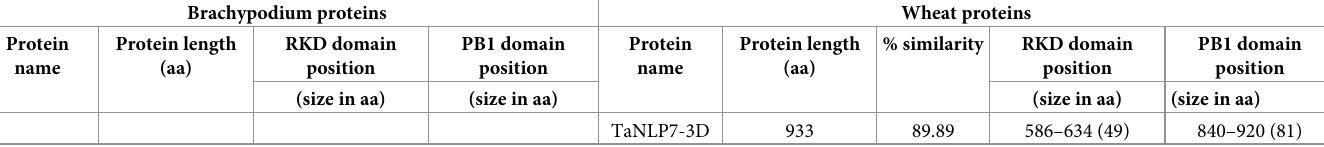
predicted 3D structures (S5 Table). The use of Ramachandran plot for evaluation of the accu- racy of protein structures is known and has been emphasized in several recent studies [27, 66]. The 3D structures of TaRKDs and TaNLPs have been submitted to Protein Model Database (PMDB) (https://bioinformatics.cineca.it/PMDB/) [67], which can be freely accessed (S5 Table). Alignment, subcellular localization and functional annotation of 3D structures. The 3D structures of three TaRKDs and four TaNLPs had significant per cent similarity with corre- sponding 3D structures of BdRKDs [range of similarity = 36.97% (TaRKD3-7A) to 88.14% (TaRKD6-2A)] and BdNLPs [range of similarity = 75.77% (TaNLP4-2A) to 95.99 (TaNLP7- 3A)], respectively (S4 Fig and S6 Table). The 3D structures of the remaining four proteins from RKD sub-family (TaRKD1-7A, TaRKD4-6A, TaRKD9-3A, TaRKD10-7A) and two pro- teins from NLP sub-family (TaNLP1-4B and TaNLP5-6A), however, did not have significant similarity ( < 30%) with 3D structures of the respective Brachypodium proteins. This may be attributed to the possible divergence of the amino acid sequences of the corresponding wheat and Brachypodium proteins.